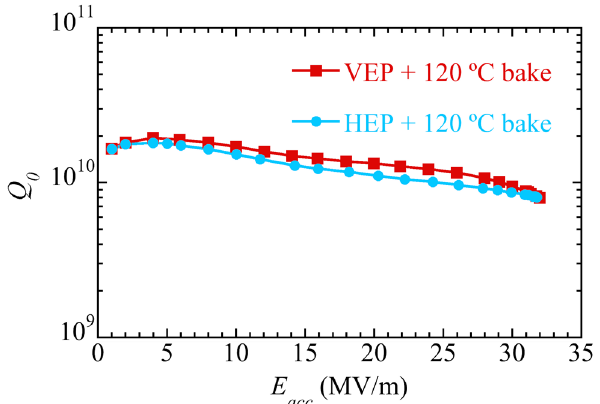
FIG. 9. Comparison of the quality factor ( Q 0 ) versus accel- erating field ( E ) curves measured at 2 K after VEP and HEP of acc a Tesla-shape 1.3 GHz single-cell Nb cavity. SRF tests were conducted after HEP performed for bulk removal and final light removal of 20 μ m, and VEP performed for removal of 36 μ m and final light removal of 10 μ m. Baking at 120 °C for 48 h was applied after the final light removals.